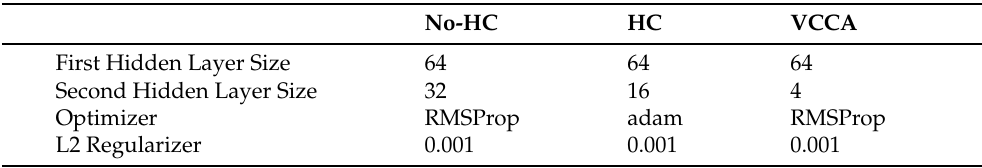
Table 9. The hyperparameters used for Dataset